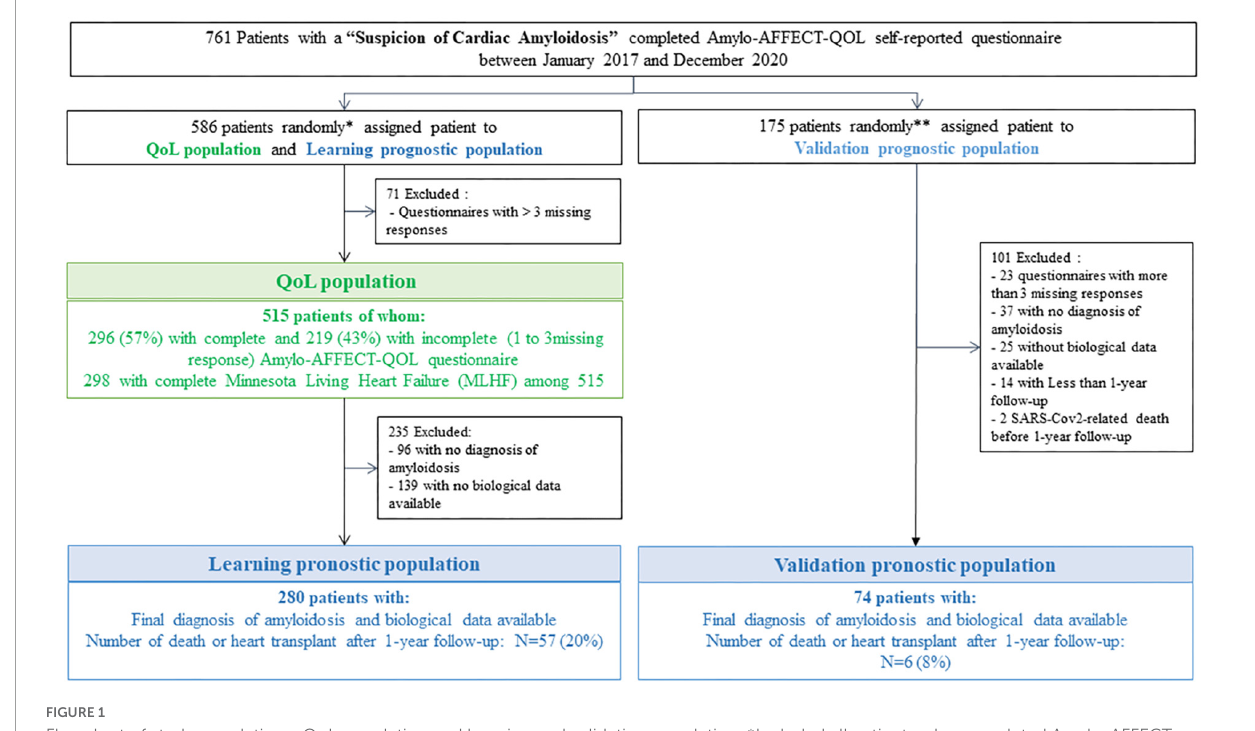
be omitted for redundancy (inter-item correlation, rs >